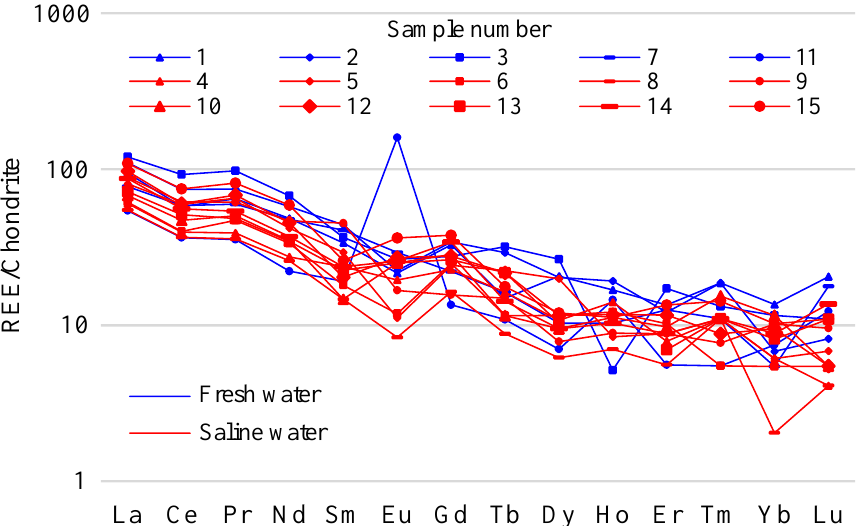
Figure 6. Spectra of REEs in lake water within Burabay District (chondrite is normalized).